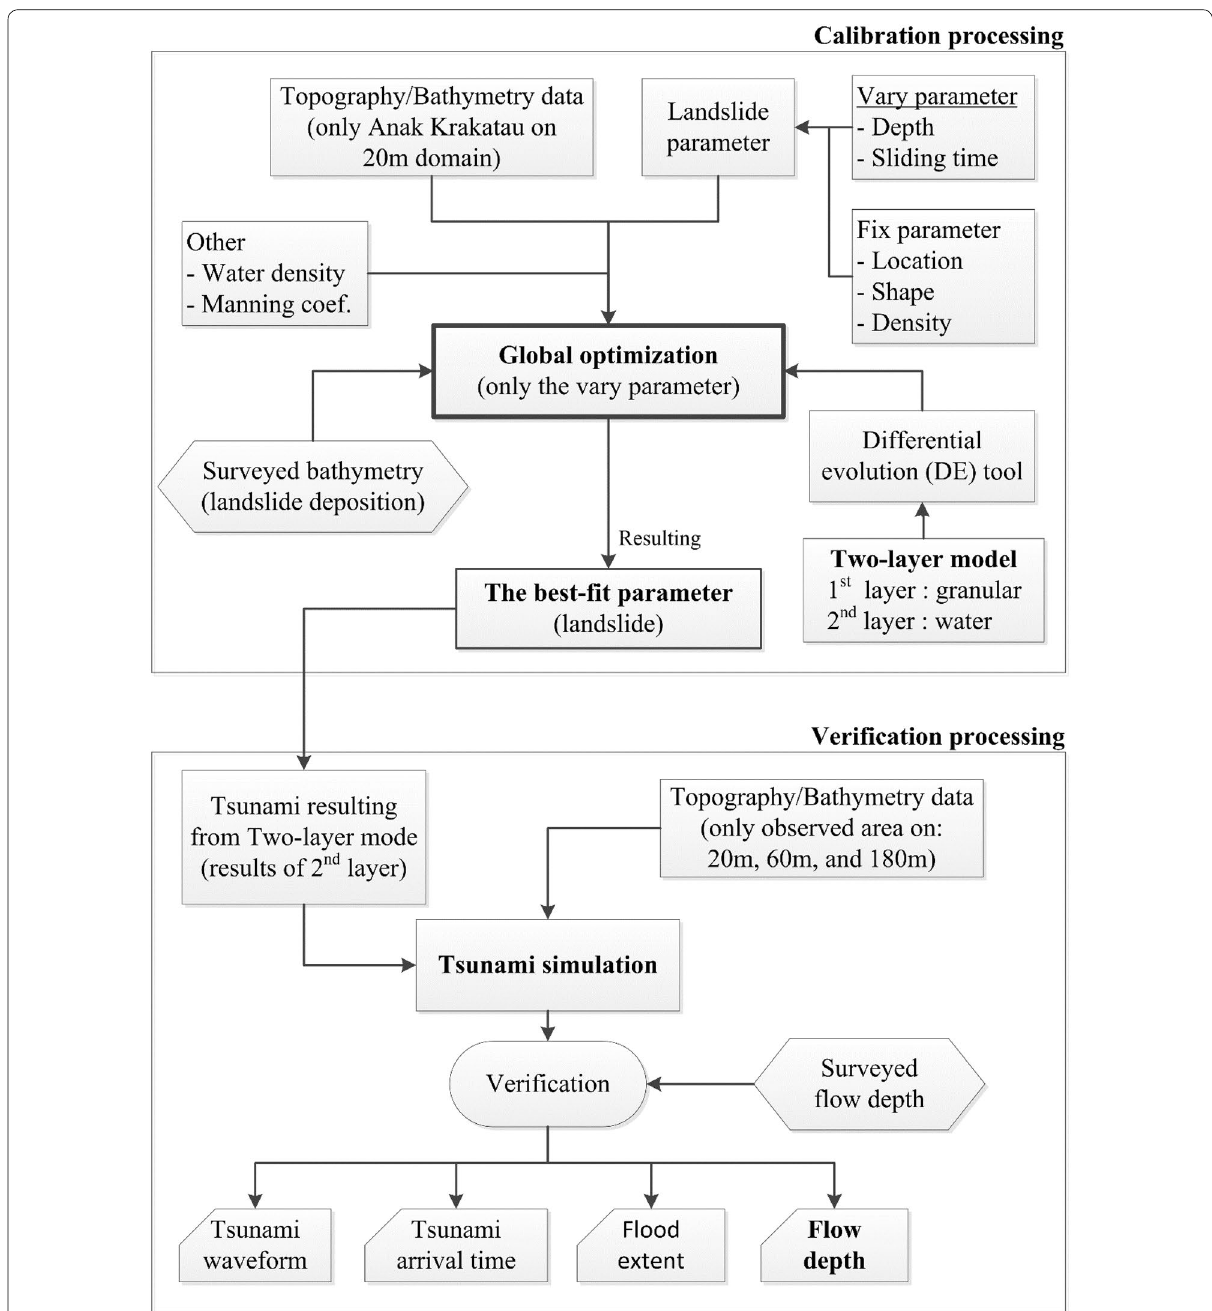
Fig. 4 General framework of this study to implement global optimization for calibration of the landslide parameter based on the two-layer model